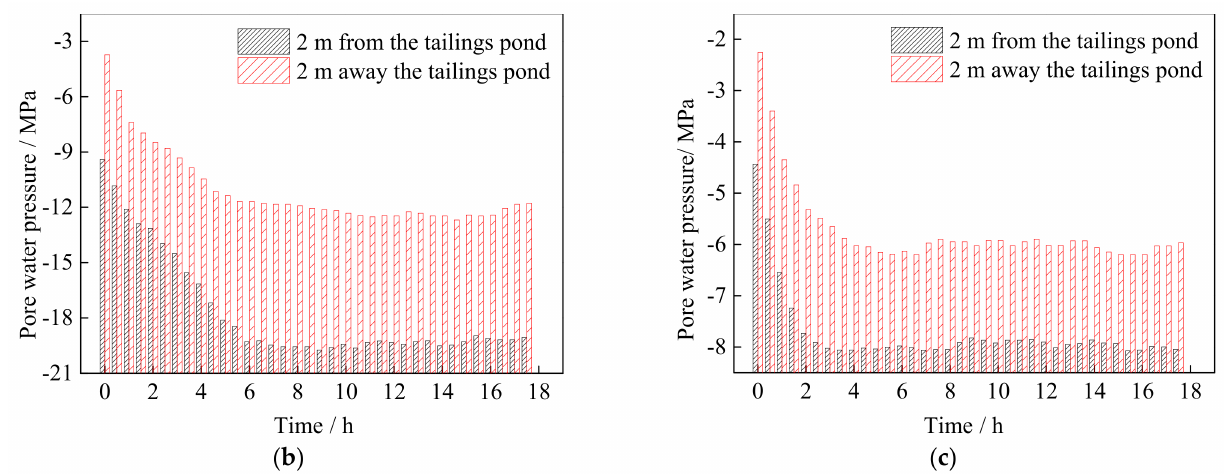
Figure 12. Relationship between PWP in the dam body and time: ( a ) geogrid-reinforced dam, ( b ) conventional dam, and ( c ) geotextile-reinforced dam.